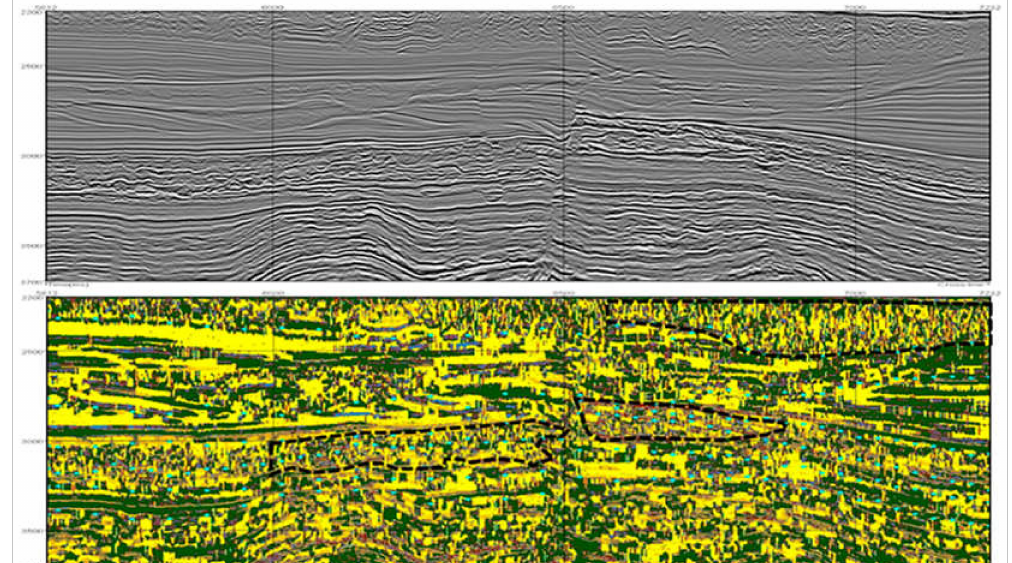
Figure 11. Results of the application of Kohonen on the best subset of seismic attributes with a rectangular map of size 6 × 6 neurons and 8 groups. At the top, the original vertical seismic slice is presented; on the bottom, each group from the Kohonen map is represented with a unique color. Black polygons indicate regions in which groups show a chaotic distribution.